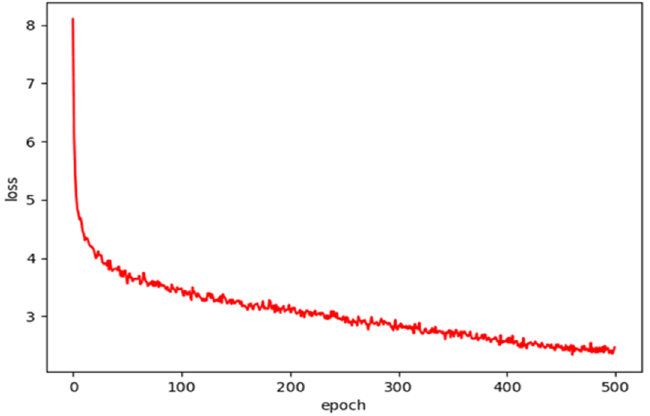
Figure 7. Training loss curve.